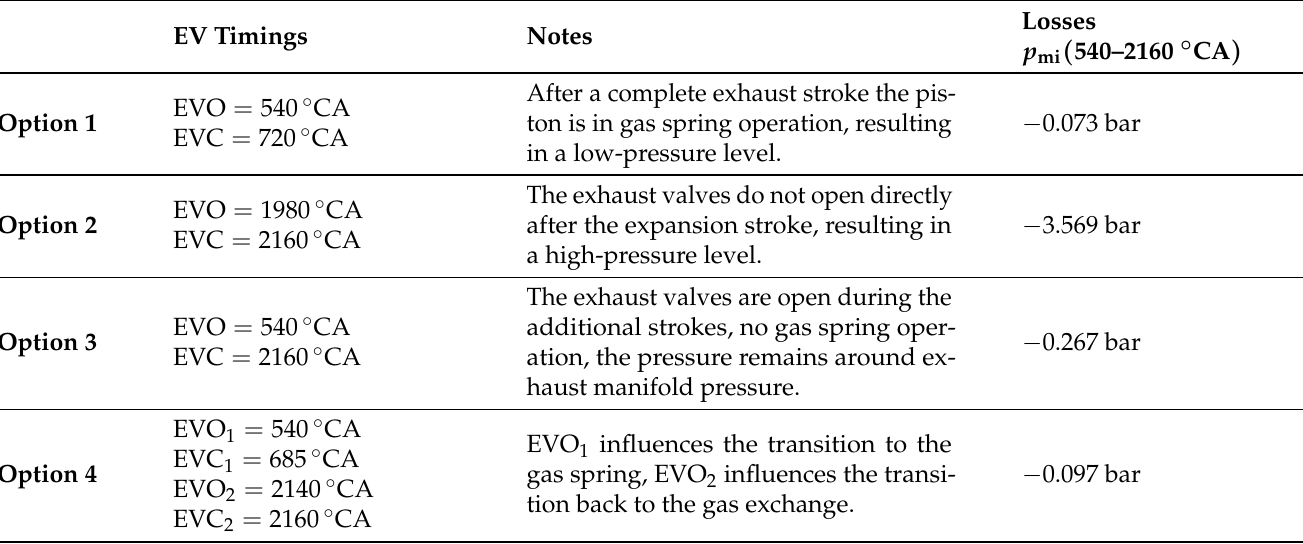
Table 4. Summary of the various gas spring options shown in Figure